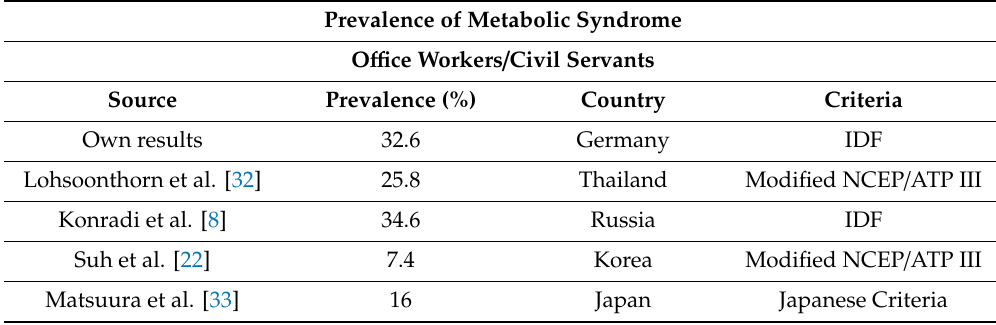
Table 8. Prevalence of metabolic syndrome in published studies.